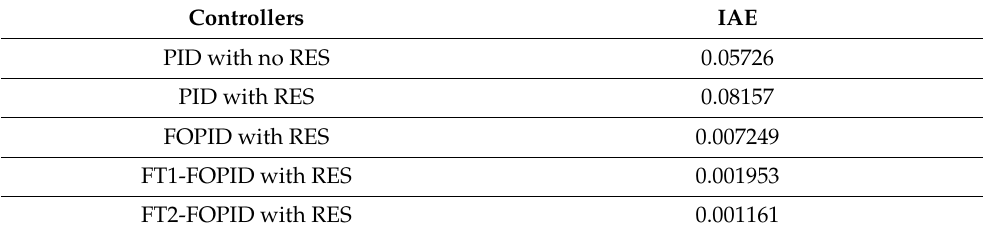
Table 4. IAE results obtained for various controllers for demand change of 1% in Area 1.